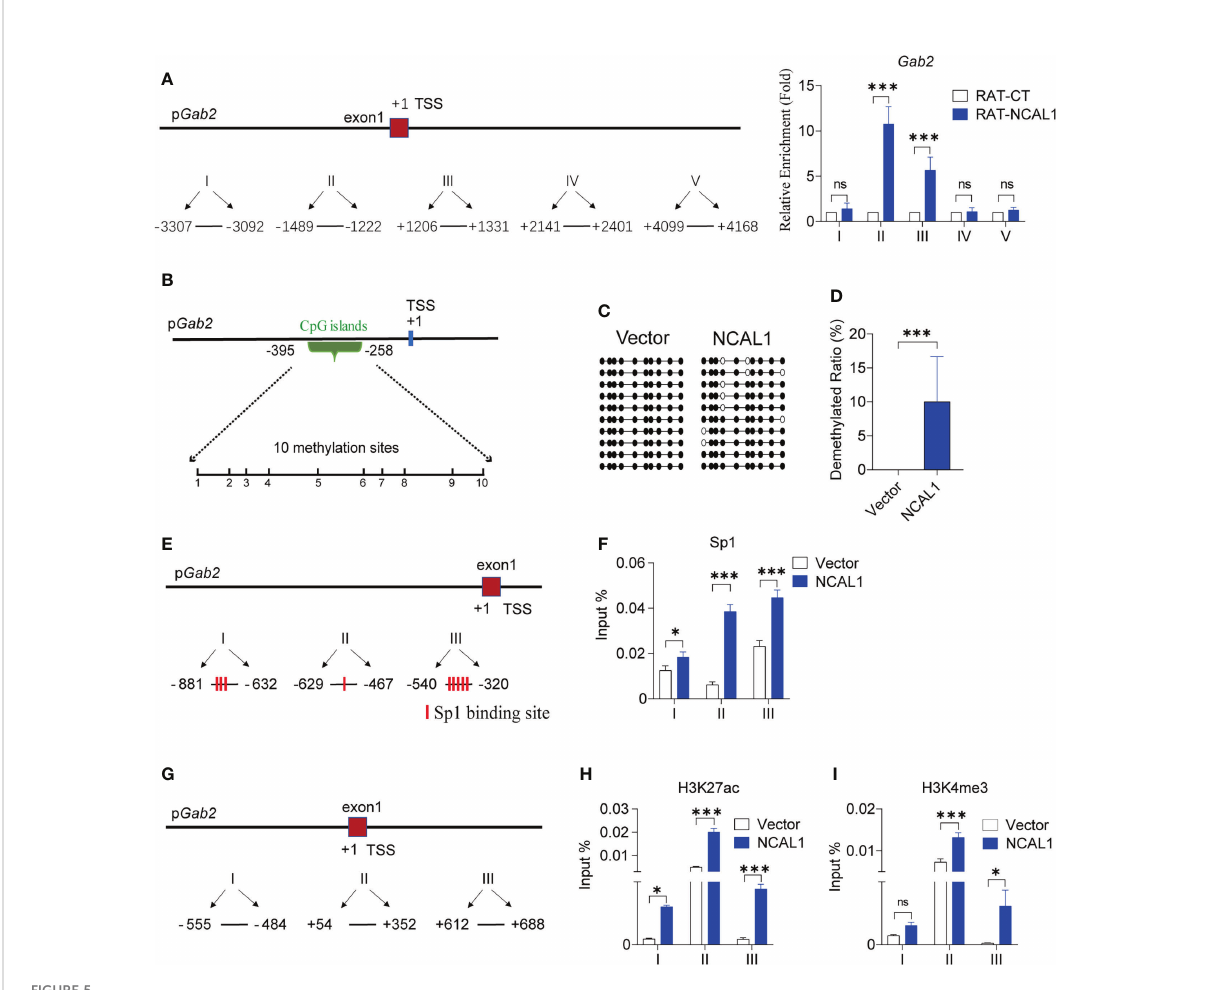
FIGURE 5 NCAL1 binds to the Gab2 promoter and epigenetically enhances Gab2 expression. (A) Quantitative real-time PCR mapping of NCAL1 binding to the Gab2 promoter. RAT pulldown assays were used to map NCAL1 binding. Note the enriched NCAL1 binding signals in the Gab2 promoter region (II, III). Data represent three independent experiments. ns: not signi fi cant; *** p < 0.001, two-way ANOVA. RAT-CT: RAT negative control. (B) Schematic diagram of CpG islands in Gab2 promoter. Vertical lines: methylation sites. (C) DNA methylation of the Gab2 promoter in NCAL1- overexpressing NK92MI cells. Open circles: unmethylated CpGs; solid circles: methylated CpGs. (D) Statistical analysis of demethylated Gab2 promoters in NCAL1-overexpressing NK92MI cells. *** p < 0.001, two-tailed unpaired t -test. (E) Quantitative real-time PCR analysis of Sp1 binding sites in the Gab2 promoter. Three pairs of primers were designed around Sp1 transcription factor binding sites in the Gab2 promoter. (F) Enrichment of Gab2 DNA sequences for Sp1 occupancy at the Gab2 promoter of NCAL1-overexpressing NK92MI cells was measured using ChIP-qPCR. Data were obtained from three independent experiments. * p < 0.05, *** p < 0.001, two-way ANOVA. (G) Quantitative real-time PCR analysis of the transcription start site near the Gab2 promoter. Three pairs of primers were designed around the transcription start position of the Gab2 gene. (H, I) Enrichment of Gab2 DNA sequences for H3K27ac and H3K4me3 occupancy at the Gab2 promoter of NCAL1- overexpressing NK92MI cells was measured using ChIP-qPCR. Data were obtained from three independent experiments. ns, not signi fi cant; * p < 0.05, *** p < 0.001, two-way